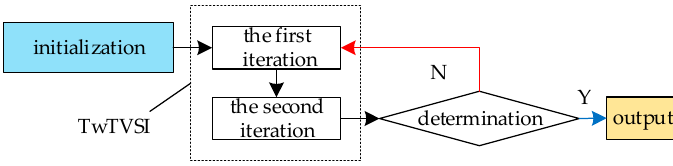
Figure 3. Block diagram of TwTVSI algorithm.